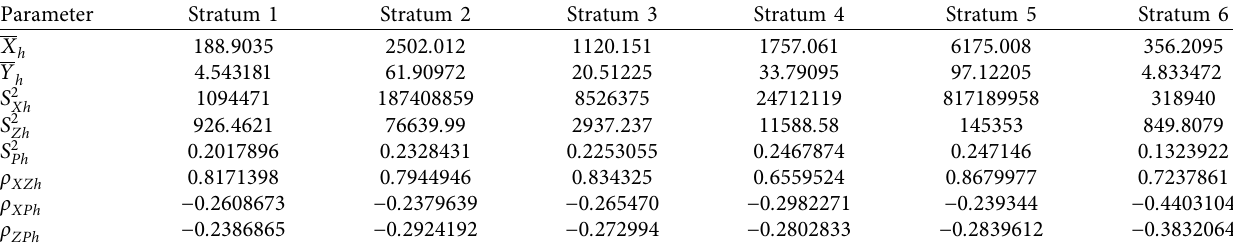
Table 1: Parameters for population I.